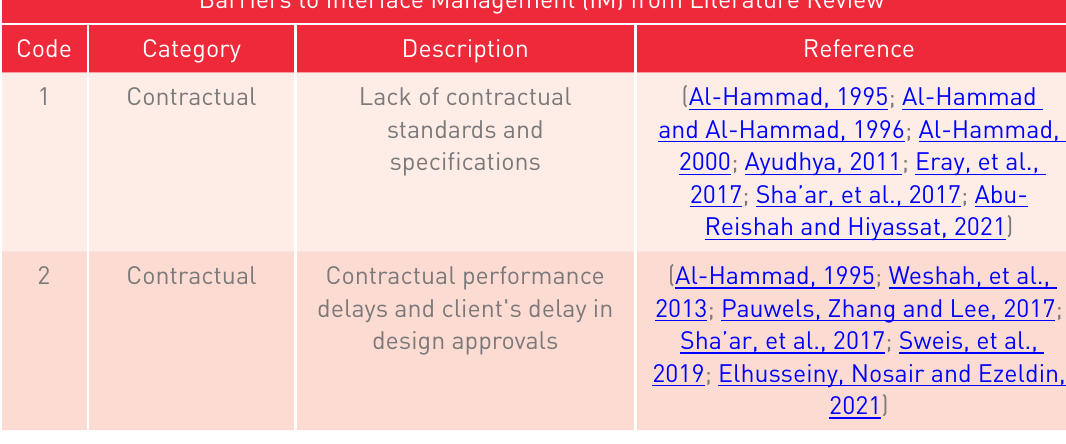
Table 1. List of Preliminary 30 barriers to IM.